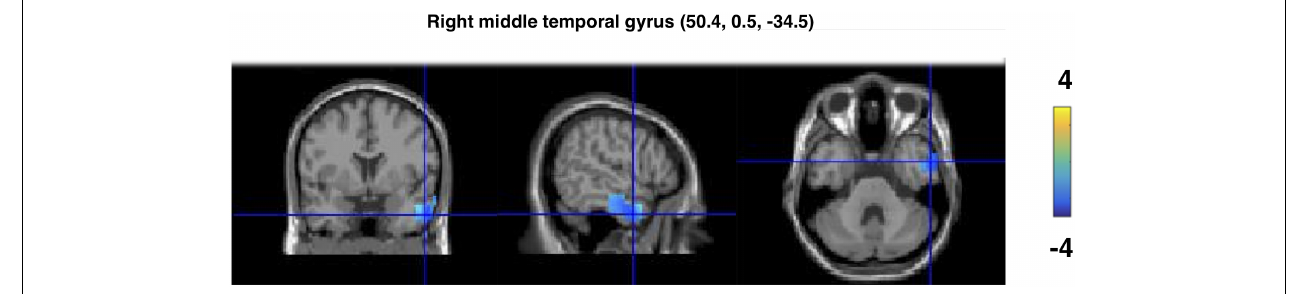
FIGURE 3 | Source reconstruction results of the gamma band effect for the MP vs. IC gesture in the co-speech condition. The sources were spatially normalized to the MNI template brain. The peak of the source is located in the right middle temporal